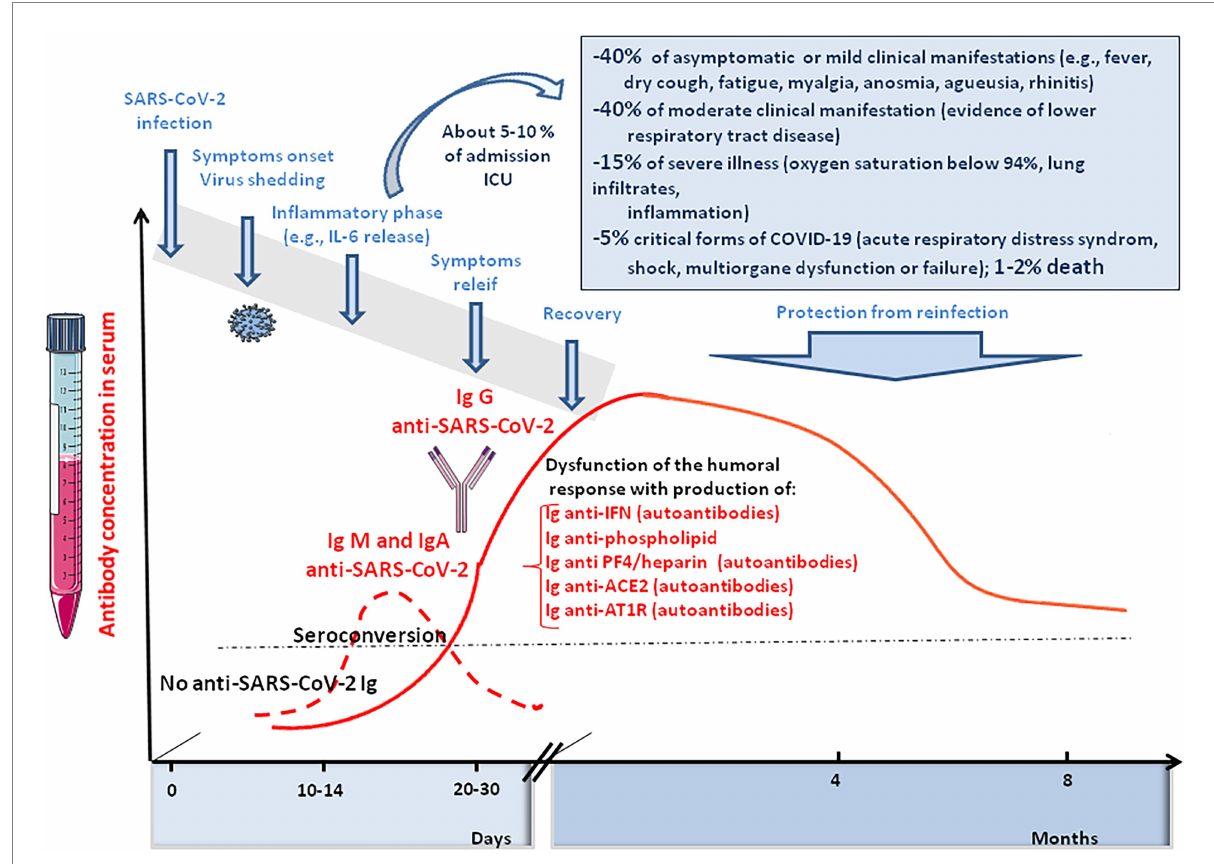
FIGURE 7 Schematic representation of the clinical course of SARS-CoV-2 infection and COVID-19. It illustrates the immune response of SARS-CoV-2 infected people, including anti-SARS-CoV-2 IgM, IgA, and IgG responses and the induction of auto-immune Ig (anti-phospholipid A, anti-PF4/ heparin, anti-ACE2, and